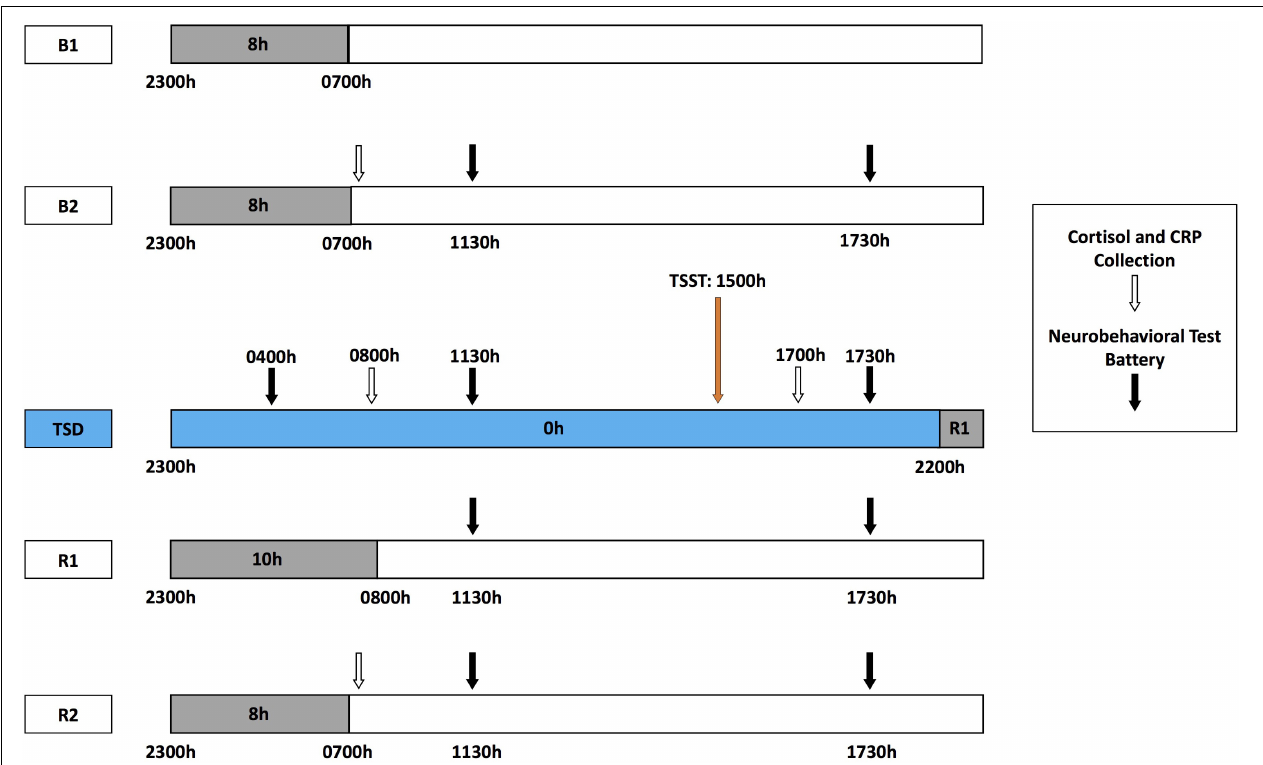
FIGURE 1 | Five-day experimental protocol. The experimental protocol consisted of 2 days of baseline with 8-h time in bed (TIB) sleep opportunity (B1, B2; 2300–0700 h). Baseline cortisol and CRP collection (white arrows) occurred at 0700 h after the B2 sleep opportunity, followed by the neurobehavioral test battery (NTB) at 1130 and 1730 h (black arrows). After the B2 day, participants began 39 h of total sleep deprivation (TSD, blue block). During TSD, NTB administration occurred at 0400 h, cortisol and CRP collection at 0800 h, and NTB administration at 1130 h. A modified Trier Social Stress Test (TSST, orange arrow) was administered starting at 1500 h during the TSD day, with cortisol and CRP collection at 1700 h and NTB administration after TSST completion at 1730 h. Recovery followed TSD, including 10 and 8 h TIB sleep opportunities (R1 and R2, respectively). The NTB was administered at 1130 and 1730 h during R1 and R2, and cortisol and CRP collection occurred at 0700 h of